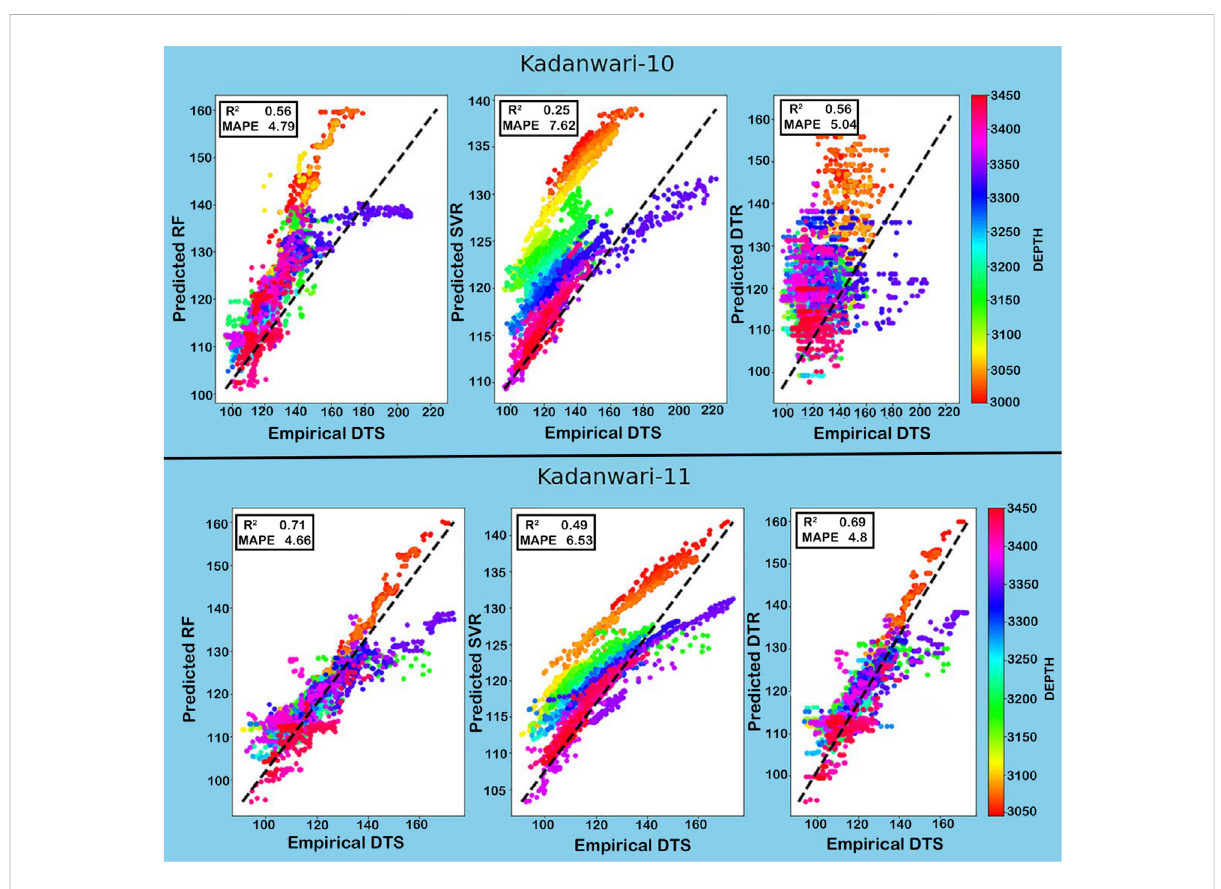
FIGURE 7 Cross plot between predicted and empirically derived DTS curves in Kadanwari-10 and -11 wells depicting RF as the best algorithm for DTS curve